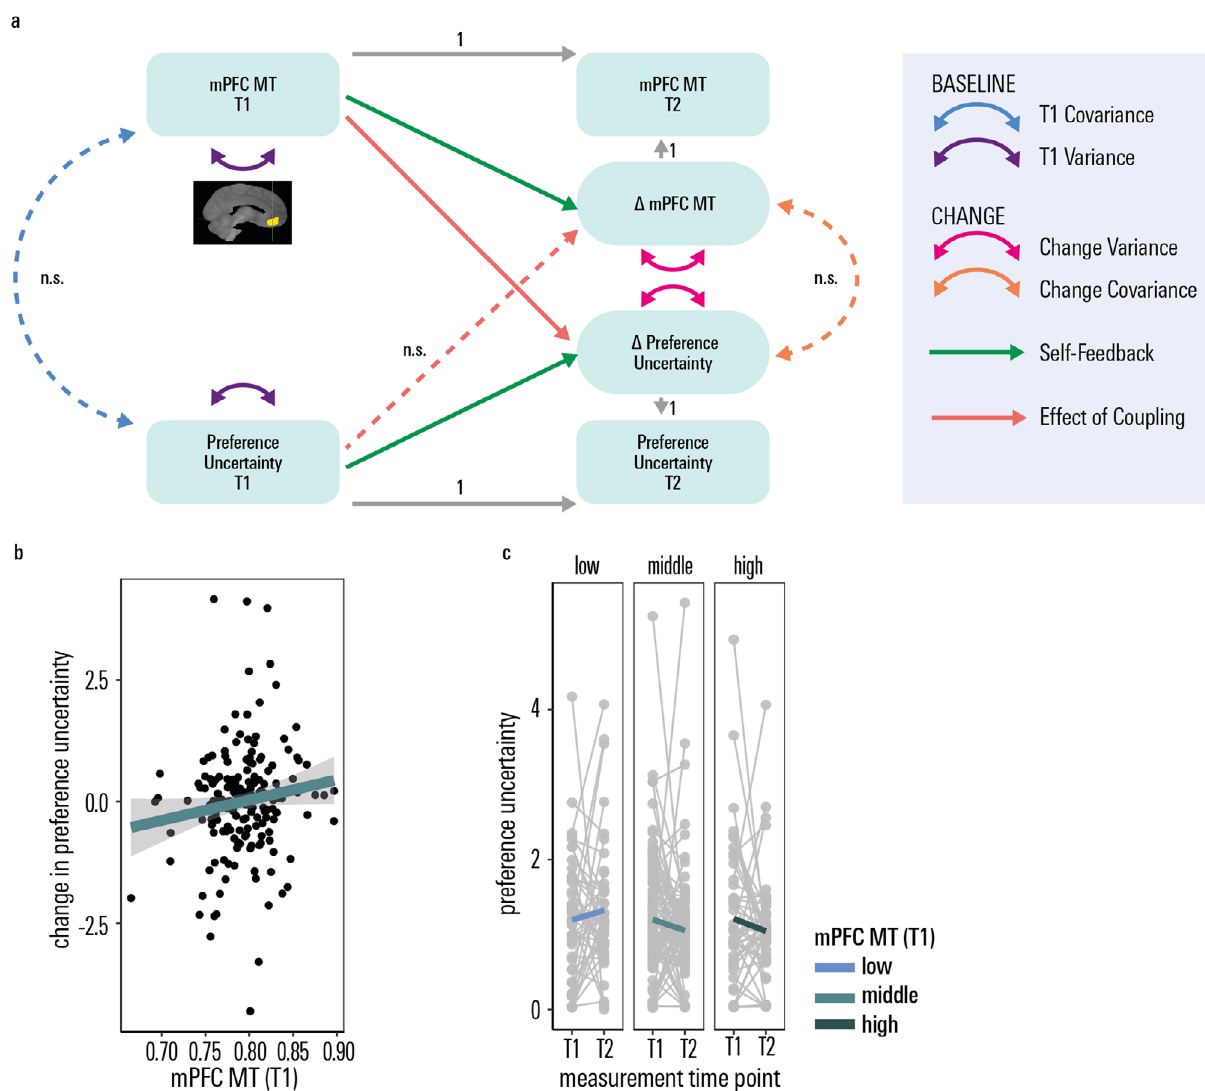
Fig. 6 Association of preference uncertainty with the mPFC myelin marker. a Bivariate latent change score model. Three developmental brain-behaviour relationships are possible and tested for by the model: (1) differences in myelin at baseline affect the rate of preference uncertainty decrease; (2) preference uncertainty at baseline predicts the degree of myelin gain between baseline and long follow-up, (3) correlated change (the degree of reduction in preference uncertainty is correlated with the degree of myelin marker change). While the path indicating the mPFC myelin marker (magnetisation Transfer) as a signi fi cant predictor of longitudinal change in preference uncertainty was signi fi cant (standardised beta = − 0.13, p = 0.03), the other cross- domain coupling paths were not. Solid lines: signi fi cant path, dashed line: non-signi fi cant path. No means are displayed for clarity; the full set of parameter estimates is included in Supplementary Table 3. b Higher values of the mPFC myelin marker (magnetisation transfer) at measurement time point 1 led to a more pronounced longitudinal change in preference uncertainty (note that a stronger longitudinal decline is coded as positive ( ‘ more change ’ ) for illustration purposes). The error band denotes the 95% con fi dence level interval. c Longitudinal decrease in preference uncertainty as a function of different levels of T1 myelin marker values. For illustration purposes, we plot preference uncertainty residuals corrected for baseline age, IQ and sex. n.s. not signi fi cant, T1 measurement time point 1, baseline assessment; T2 measurement time point 2, follow-up assessment after ~1 – 5 years, mPFC medial prefrontal cortex, MT Magnetisation Transfer. Source data are provided as a Source Data fi